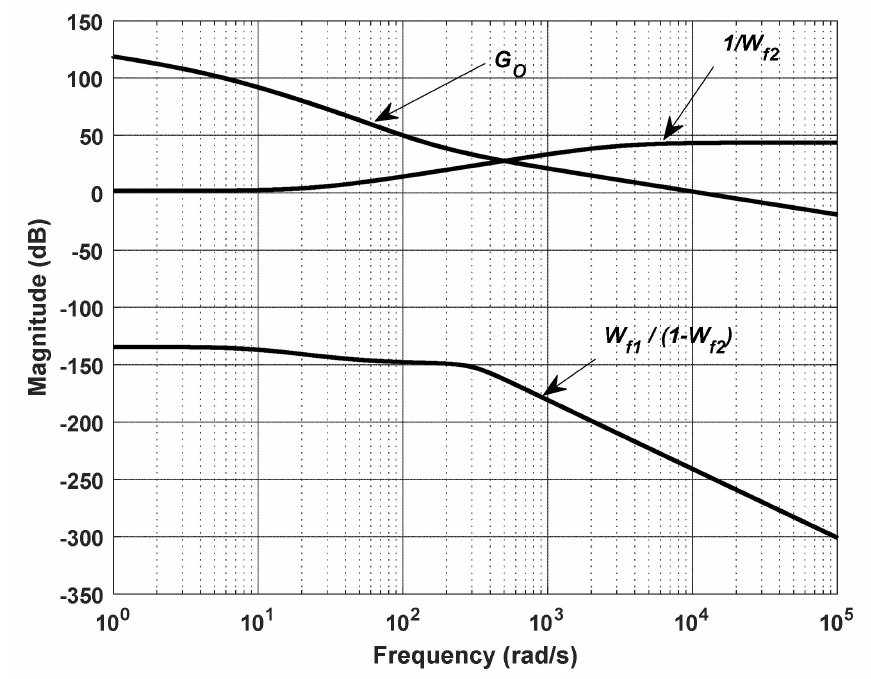
Figure 10. Loop shaping plots showing W f 1 , W f 2 , and G O .